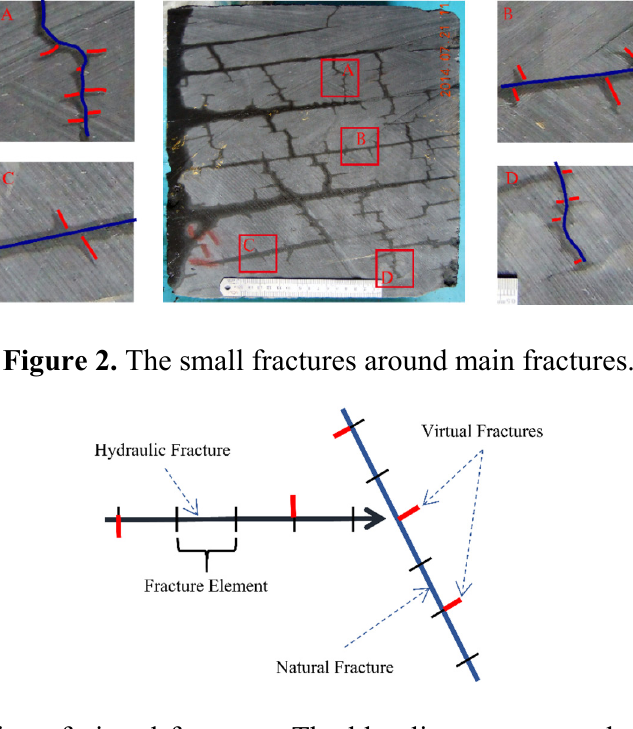
Figure 3. The setting of virtual fractures. The blue line represents the NF, the black line represents the HF, and the small red lines represent the virtual fracture